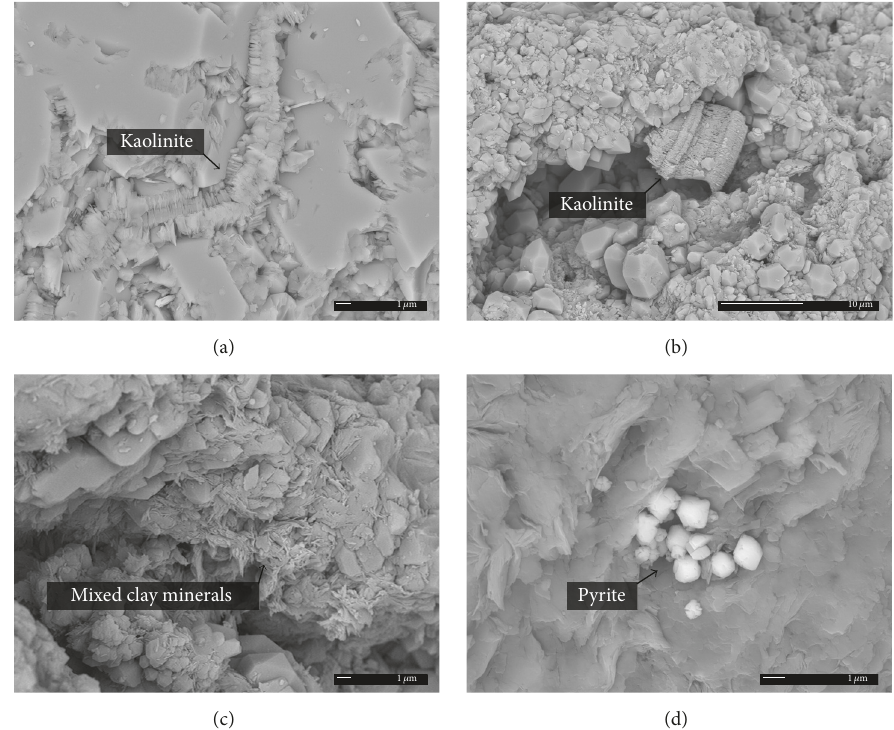
Figure6:SEMelectronbackscatterimagesofprecipitatedsecondarymineralsbySO 2 -CO 2 -waterinteractionintheexperiments:(a)kaolinite in pure CO 2 case, (b) kaolinite in 0.1% SO 2 case, (c) mixed clay minerals in 0.1% SO 2 case, and (d) pyrite in 1% SO 2 case.